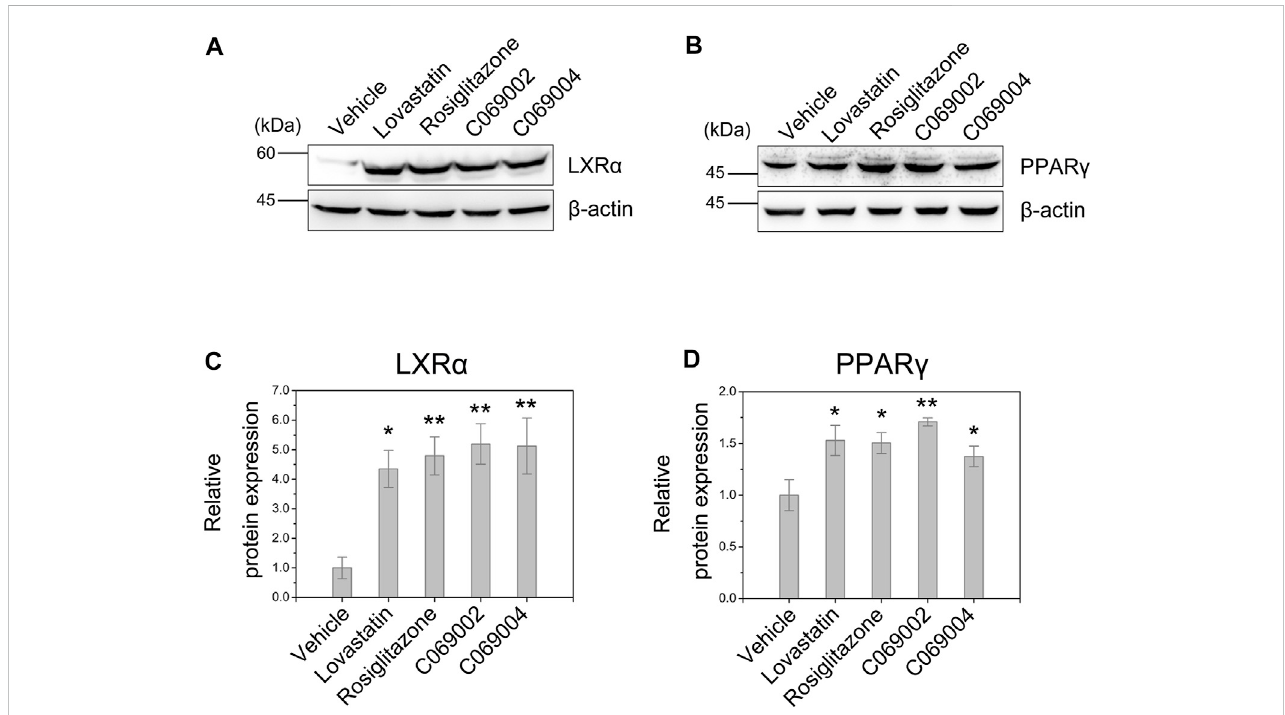
FIGURE 6 Diterpenoids enhance PPAR γ and LXR α expression. RAW264.7 macrophages were treated with 15 μ mol/L indicated drugs and chemical compounds for 24 h.Celllysateswerecollected,andtheproteinlevelsofPPAR γ (A) andLXR α (B) weredeterminedbywesternblotting.Correspondingquantitativeresultsare shown as the mean ± SEM from three independent experiments (C,D) . Signi fi cance is presented as * p < .05 and ** p < .01 versus the vehicle (DMSO)